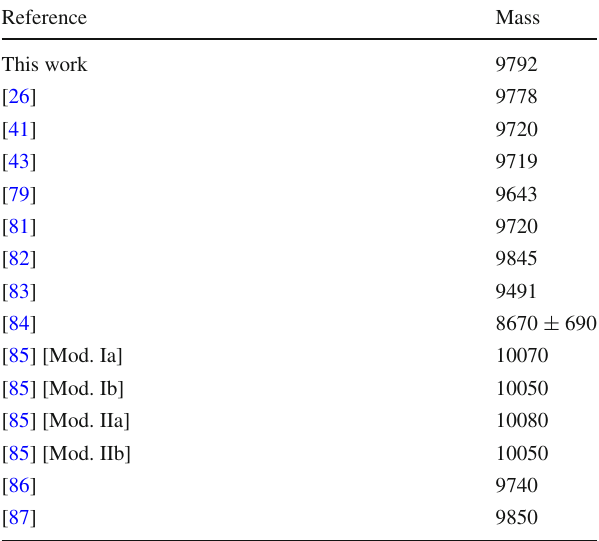
Table 6 Comparison of bb diquark masses of this work and results from other works. All diquarks are considered to be in the ground state N 2 S + 1 L J = 1 3 S 1 . All results are in